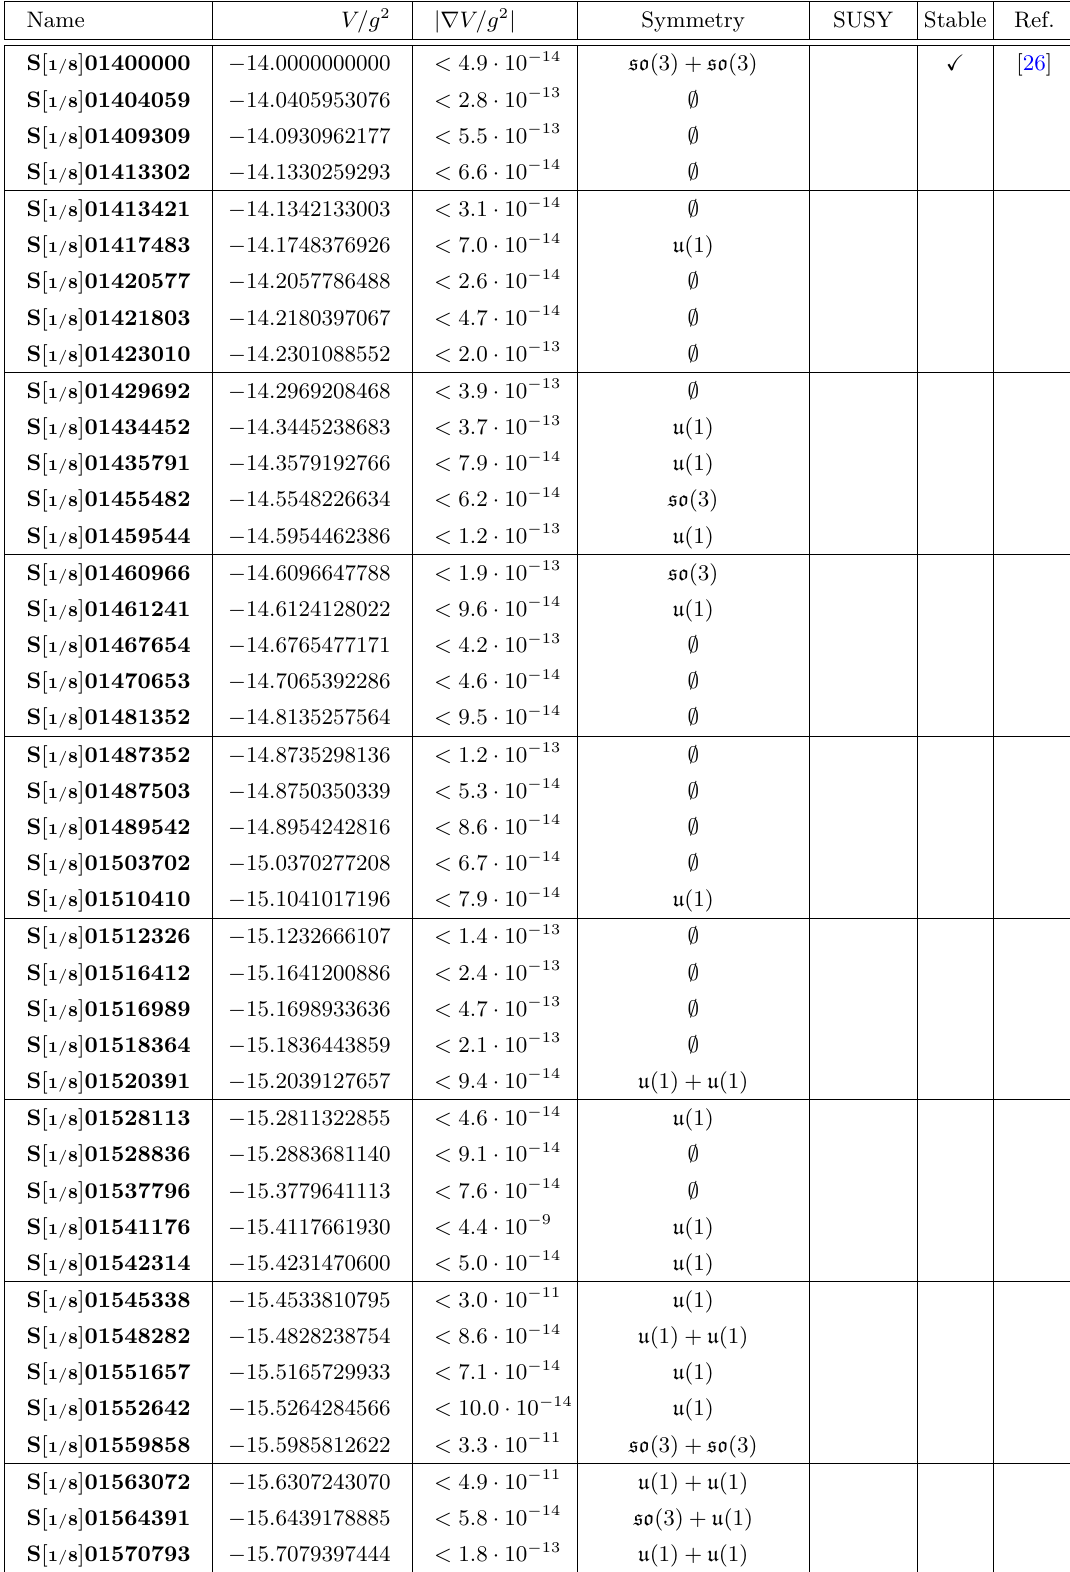
Table 1. Summary of vacua at ω = π/ 8